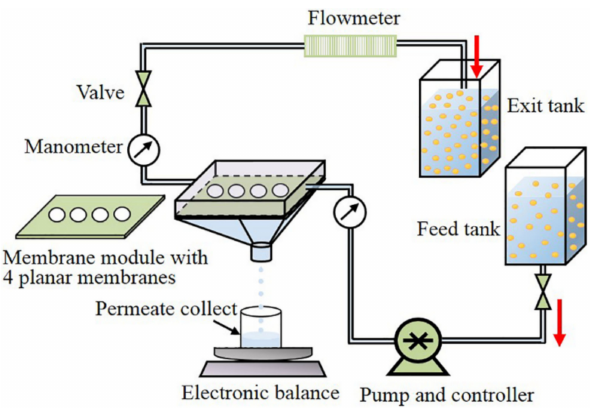
Figure 1. Schematic representation of the cross-flow filtration system used in the microfiltration